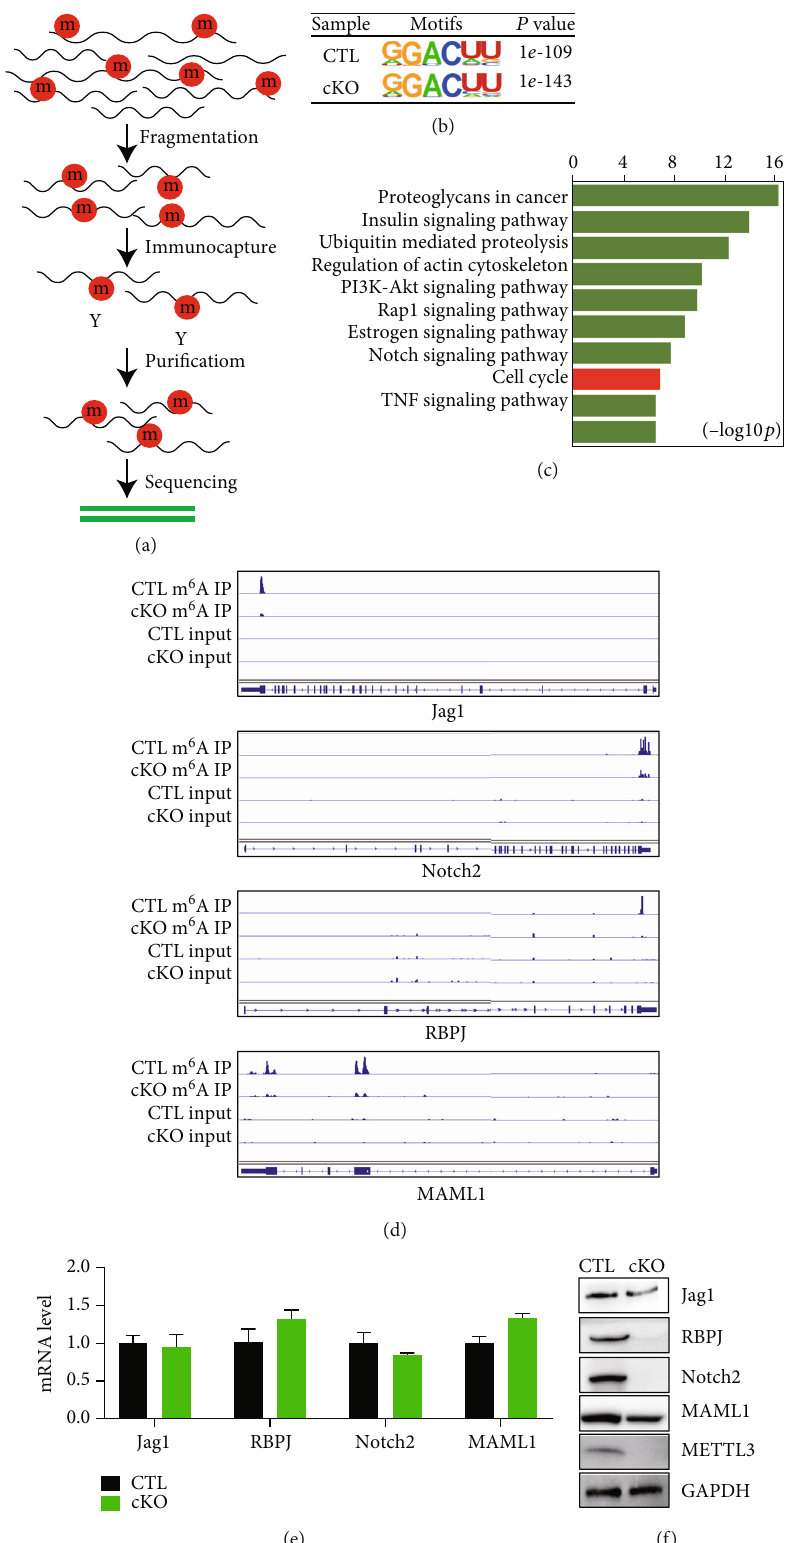
Figure 4: METTL3 regulates m 6 A modi fi cation of Notch signaling pathway components. (a) Schematic representation of m 6 A MeRIP-Seq. (b) m 6 A motif identi fi ed in the MeRIP-Seq. (c) Enriched KEGG molecular function pathways identi fi ed from di ff erentially m 6 A-enriched genes in METTL3 cKO vs. CTL D2 samples. (d) Notch signaling pathway identi fi ed in the MeRIP-Seq. (e, f) qRT-PCR and Western blot analyzed of Notch signaling pathway. CTL: control; cKO: METTL3 conditional